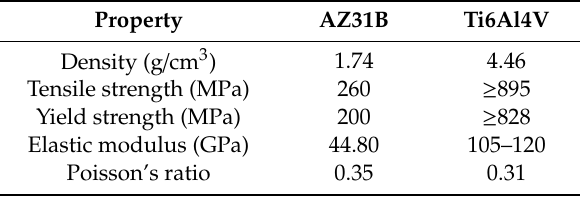
Table 3. Physical and mechanical properties of the magnesium alloy AZ31B and titanium alloy Ti6Al4V.